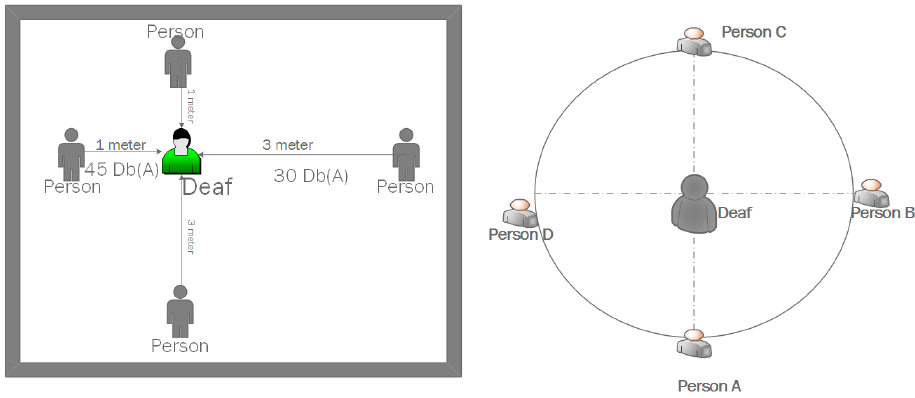
Figure 5. Testing wearable system.